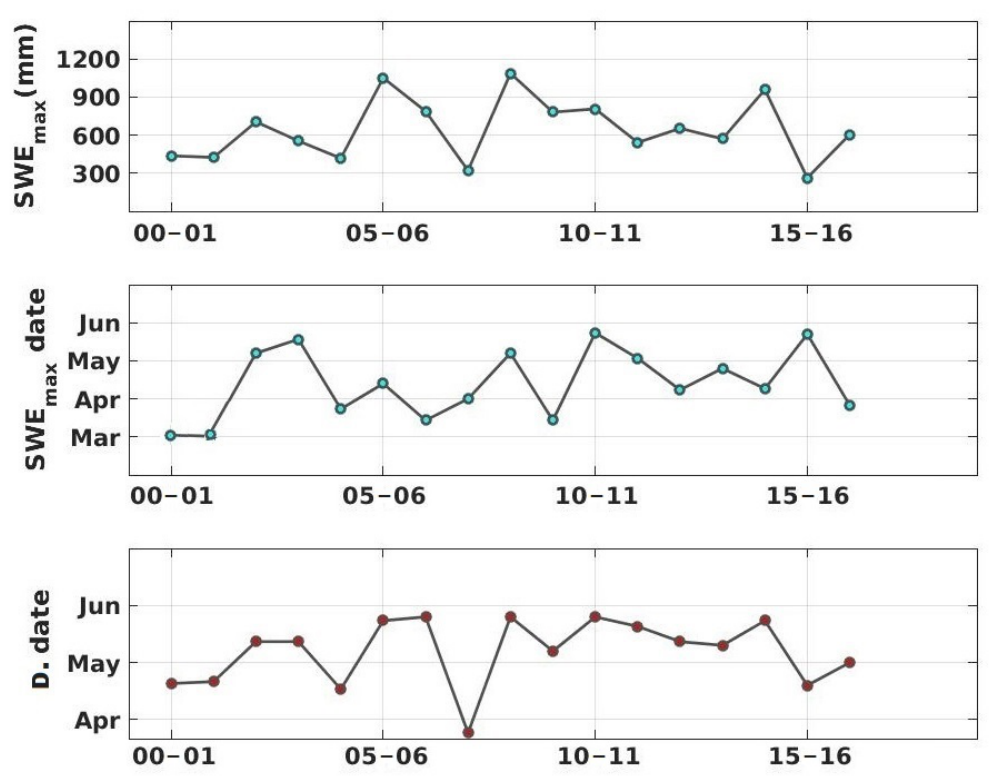
Figure 11. From top to bottom: annual values of the maximum simulated SWE, the date of maximum SWE and D.date, representing the snow disappearance date (first day after 1-March that has SWE = 0).